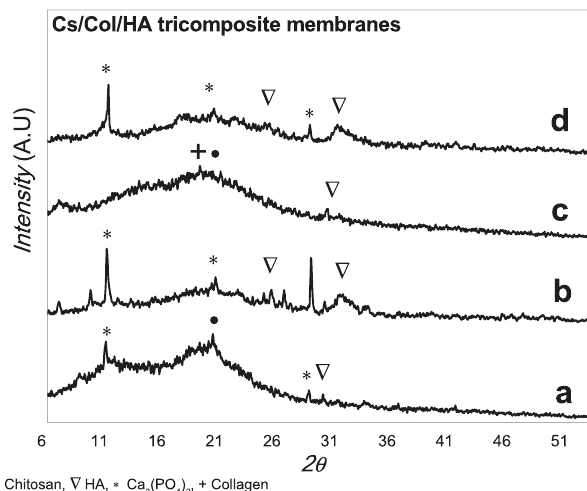
Fig. 2 X-rays diffractograms of the different tri-composite Cs/ Col/ HA membranes: a TC1. b TC2 c TC3 d